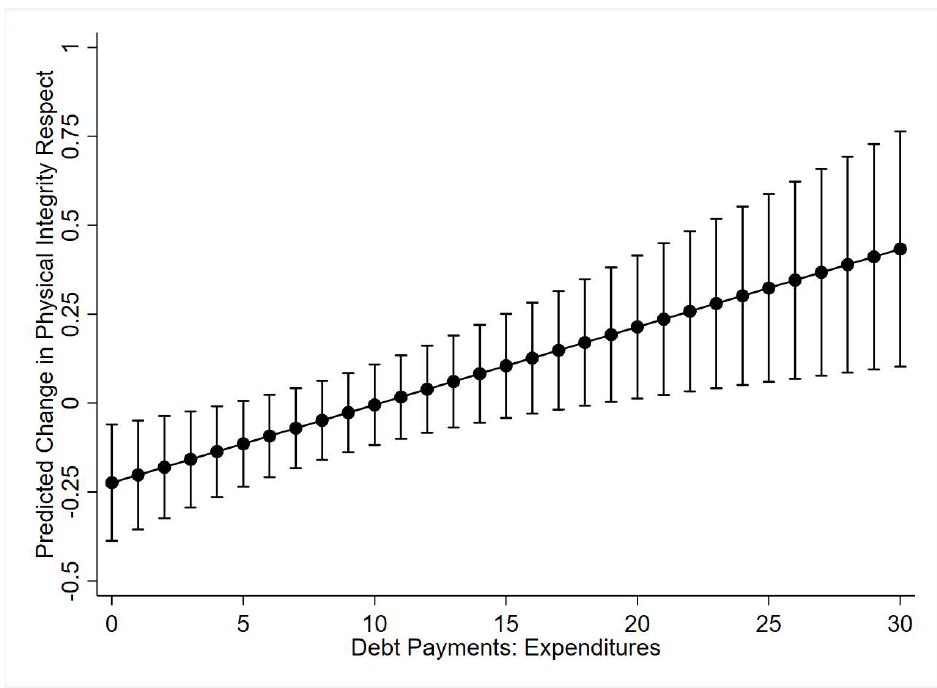
Figure 3. Marginal Effects of Default and Increasing Debt:Expenditures (95% Cis).